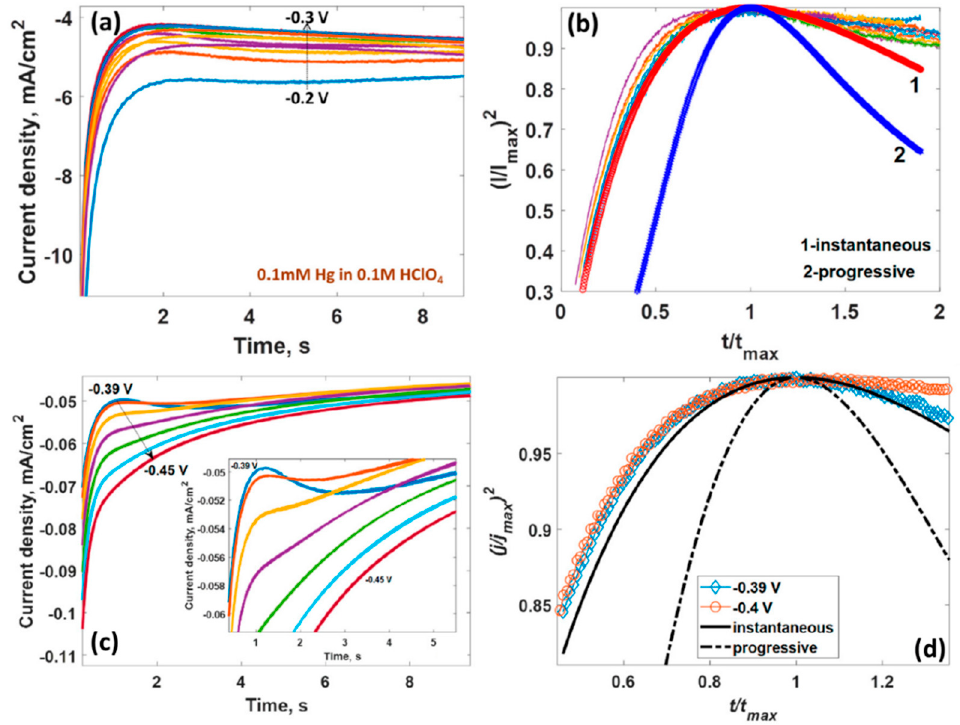
Figure 12. Current transients recorded on epitaxial graphene electrodes during mercury [51] ( a , b ) (Copyright 2019 by the authors) and copper [52] ( c , d ) (Copyright 2020 by the authors) electrodeposition. ( b , d ) also encompass the comparison of the normalized current transient curves with theoretical curves determined by the Hills–Scharifker methodology.